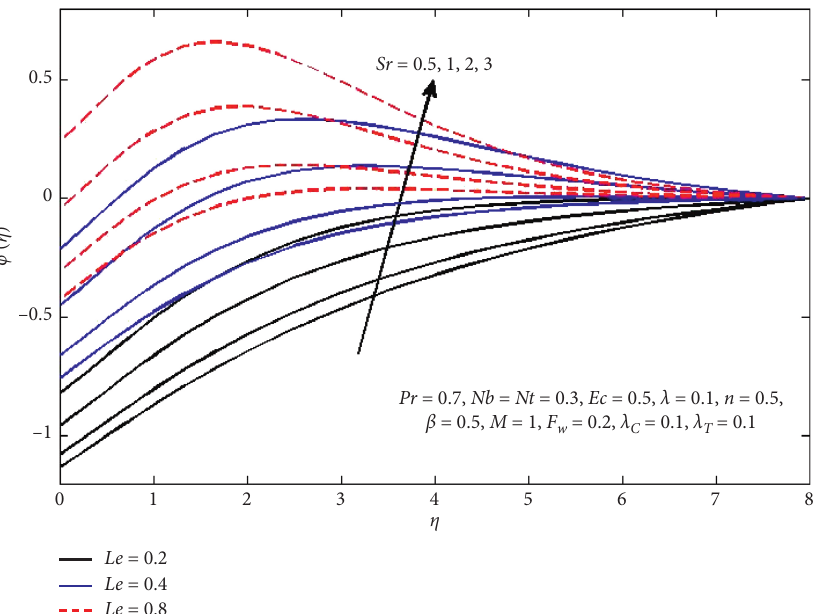
Figure 22: Variation of concentration ϕ concerning η with various values of Sr and